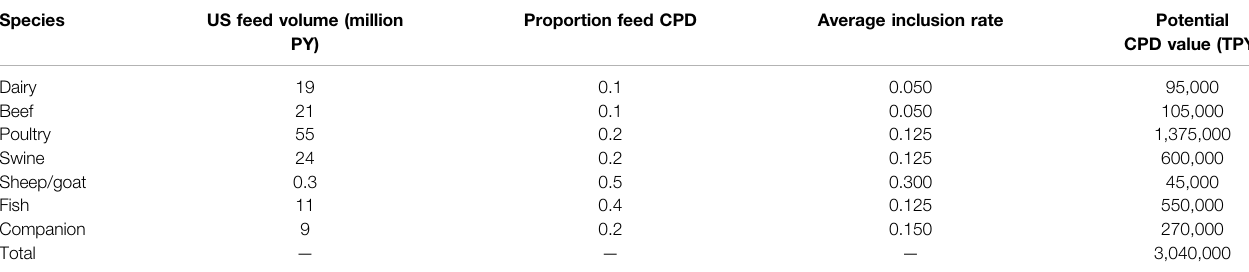
TABLE 4 | Potential US animal feed market for enhanced digestible BSG, HFM, and DDGS.